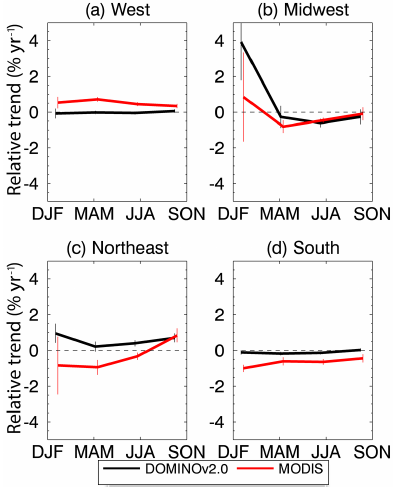
Figure 6. Seasonal relative trends of NO 2 calculated from the AQS in situ measurements (“AQS”, black line) and those derived from OMI data after applying the lightning filter (“OMI (lightning fil- ter)”, red line). The error bars represent 95th-percentile confidence intervals. The coincident data points are less than those used in Fig. 4, and therefore the AQS trends are not the